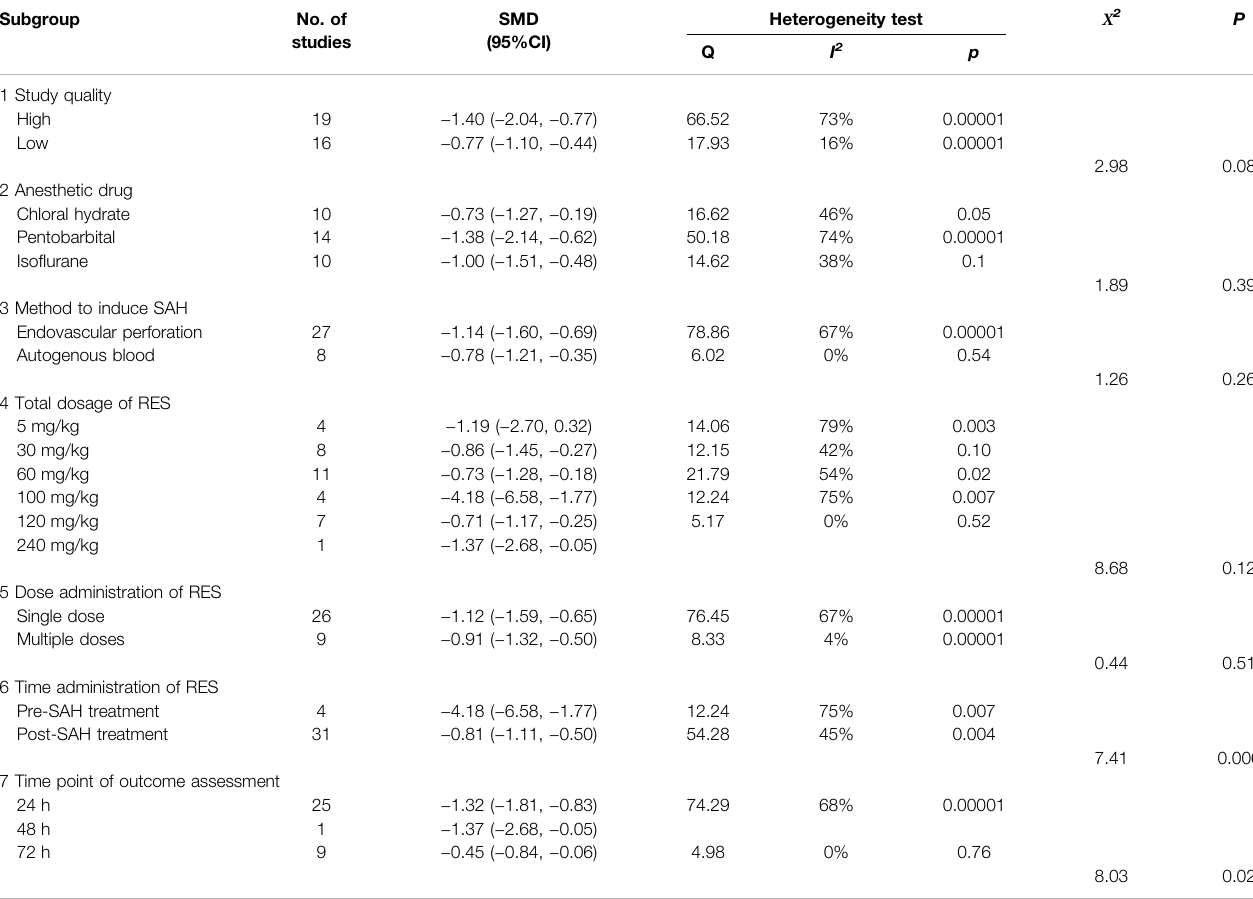
TABLE 3 | Strati fi ed meta-analysis of brain water